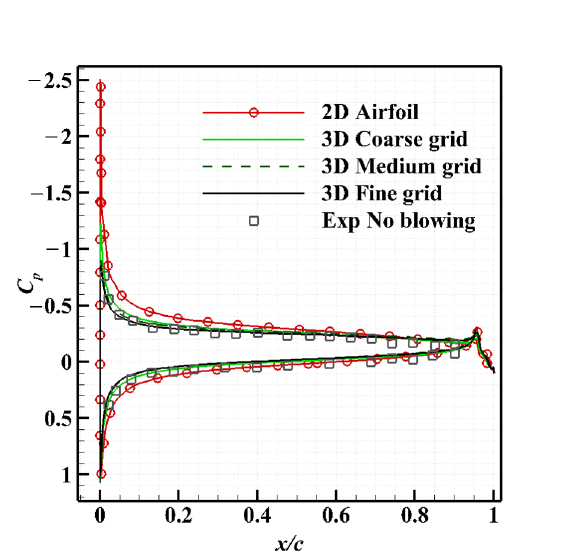
Figure 4. Comparison of C p on the midspan wing section of the unblown case ( Ma = 0.3, α = 3 ◦ ). Computational domain of